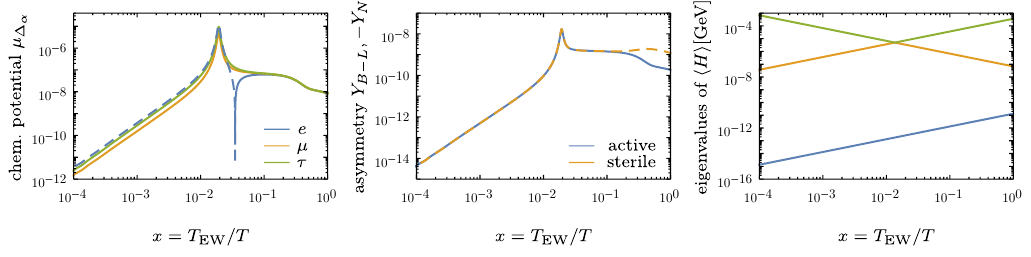
Figure 4 . Benchmark point I). Left: asymmetries in the individual active (cid:13)avours. Center: sum of asymmetries in the active (blue) and sterile (orange) (cid:13)avours. Right: eigenvalues of the e(cid:11)ective Hamiltonian h H i . Continuous (dashed) lines indicate positive (negative) values.